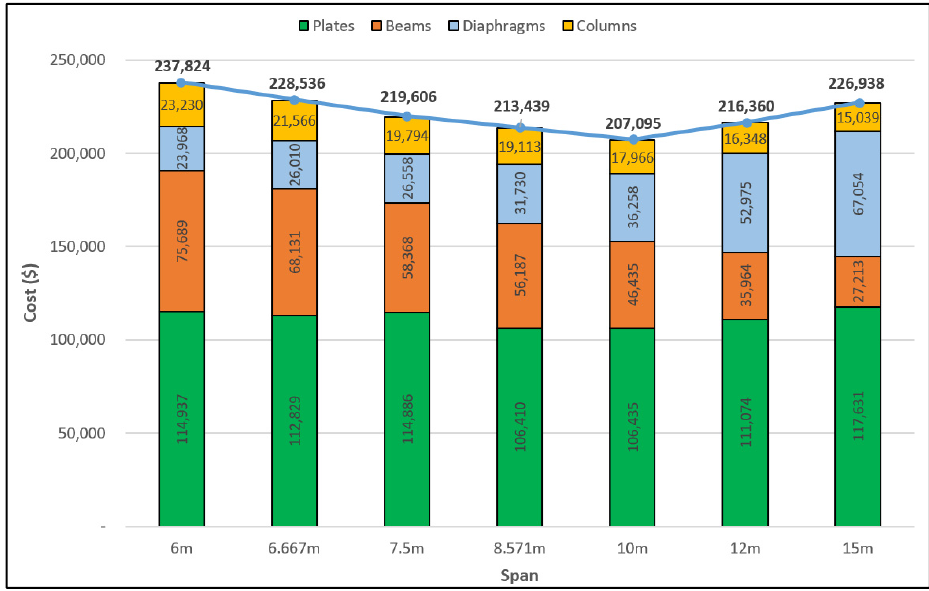
Figure 24. Cost components of the optimum designs achieved at different transverse spans for the three-segment type folded plate roof building.